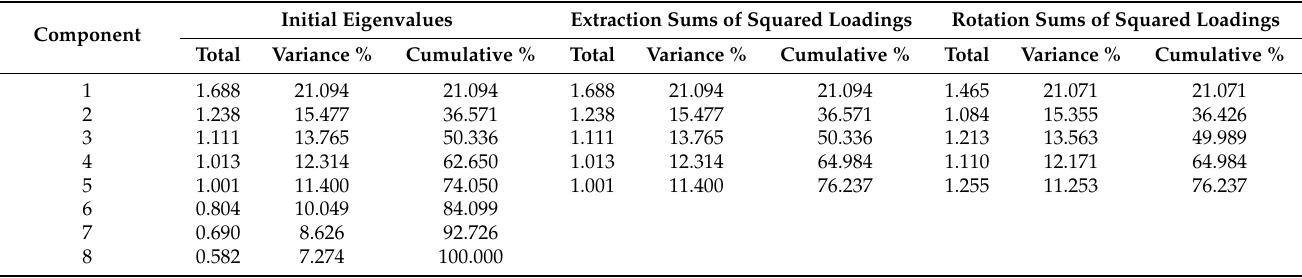
Table 10. Eigenvalues and variance explained with extracted factors (shaded) of HI, HEC, HsoL, and SSN on the overall cyclone resilience index.